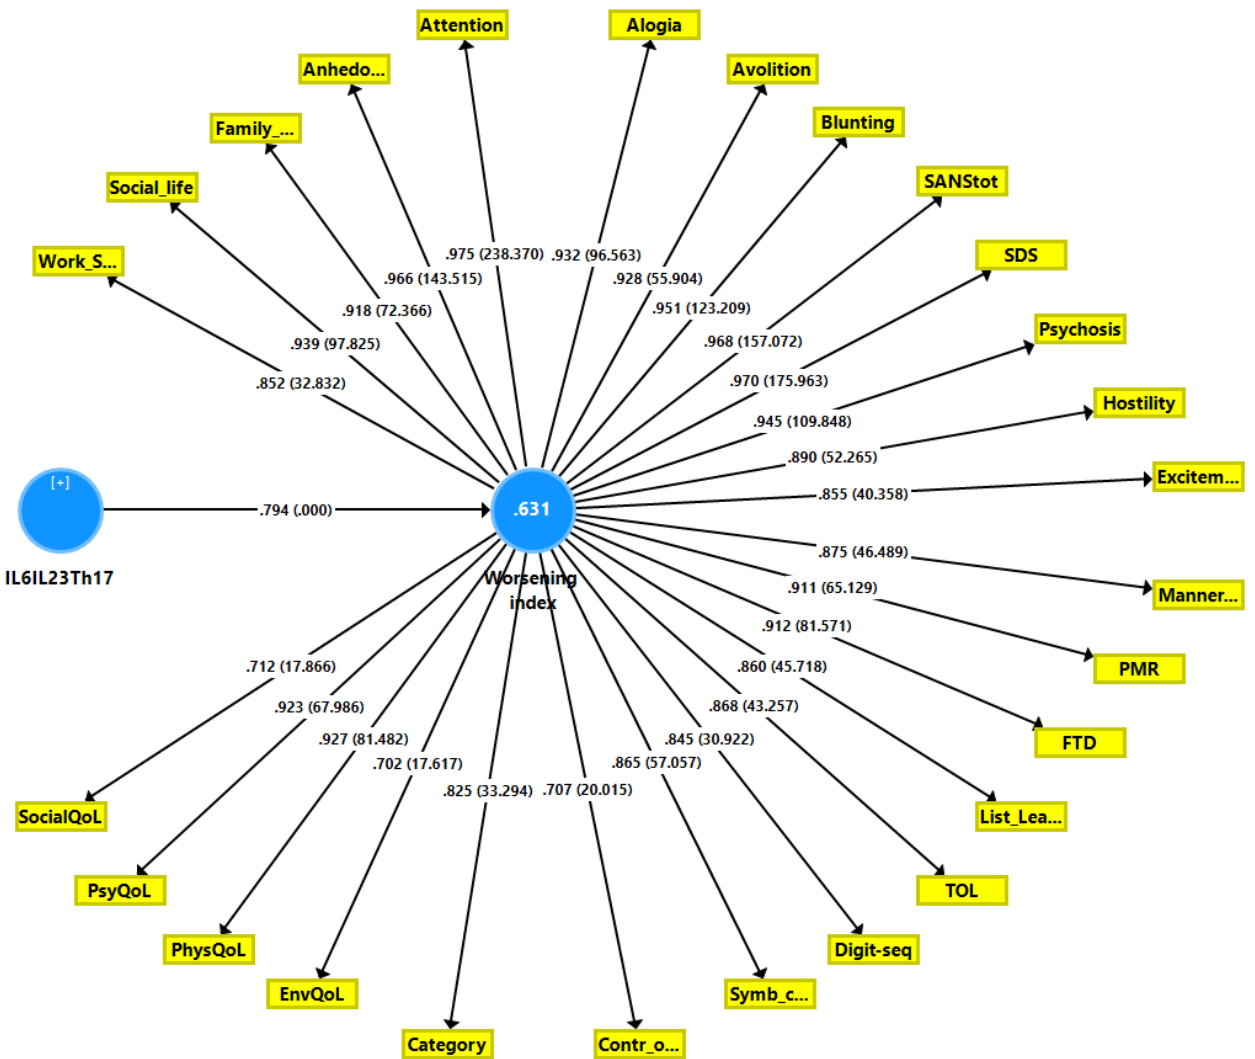
Figure 4. Results of a second Partial Least Squares path analysis. This PLS analysis examines the associations between the IL6IL23Th17 (interleukin, T helper) axis score and the worsening index, a factor extracted from three Sheehan disability domains, four health-related quality of Life (QoL) data, the symptomatome and the G-CoDe (generalized cognitive decline). See Figure 1 for further explanation. Shown are path coefficients with p -value, the factor loadings with p -value and explained variance (white figure in the blue circles).